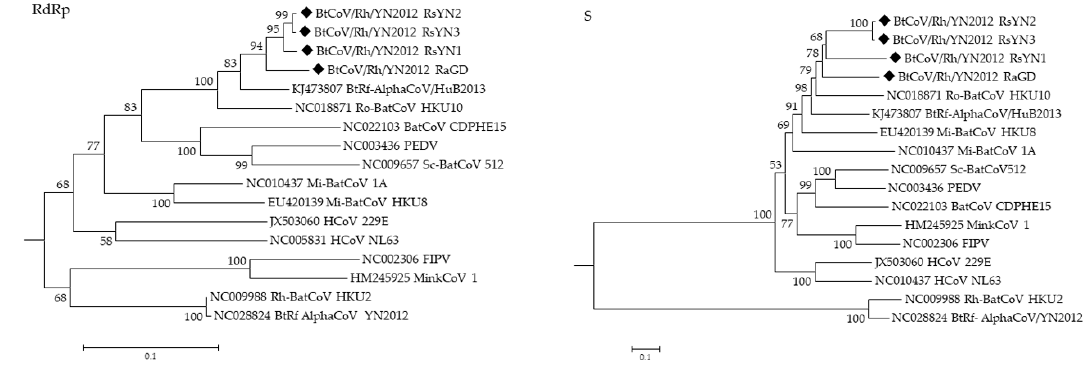
Figure 4. Phylogenetic trees generated based on aa sequences of RdRp and S. Trees were constructed by the maximum likelihood method using the Poisson model with bootstrap value determined with 1000 replicates. The scale bar indicates the estimated number of substitutions per 10 amino acids. Filled diamonds indicate viruses detected in this